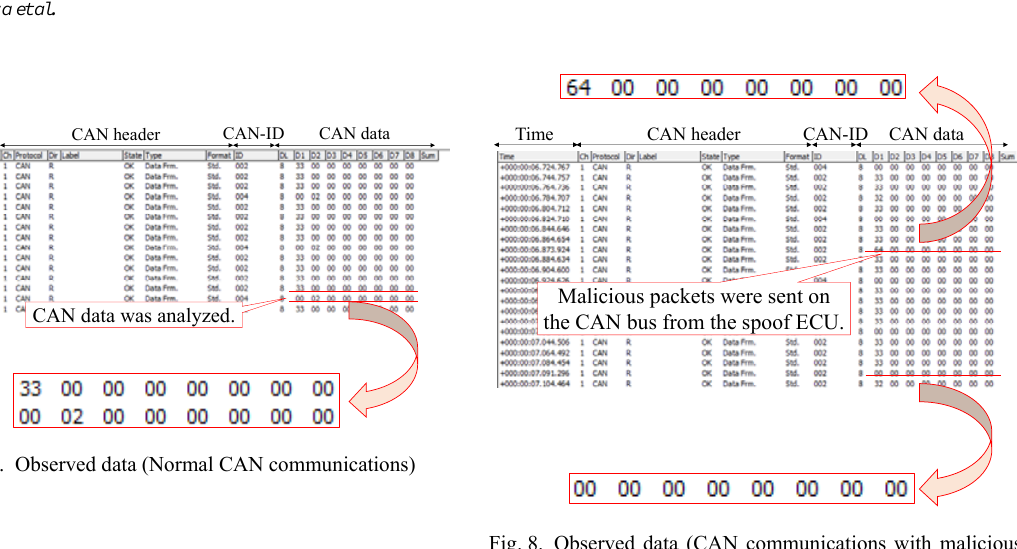
Fig. 8. Observed data (CAN communications with malicious